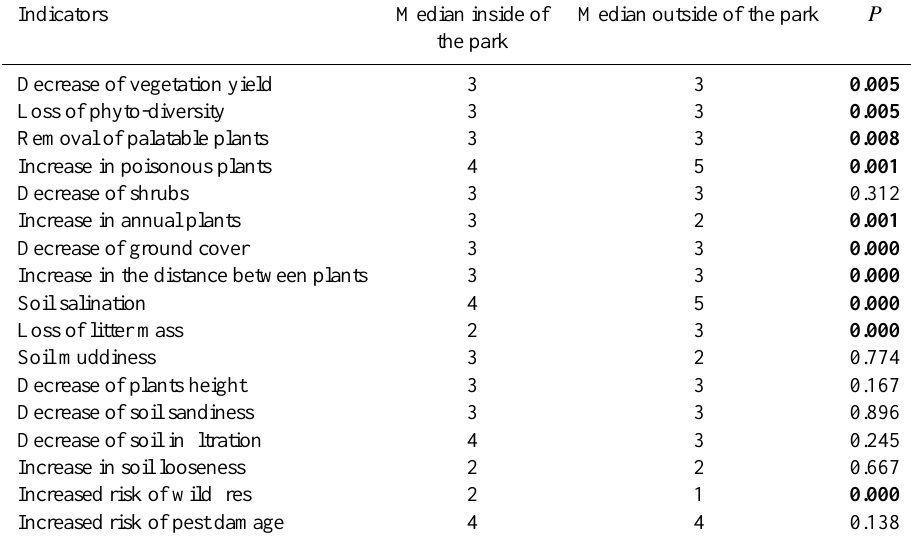
Table 2. Comparison of degradation indicators between inside and outside the park for both sites as total. P values below 0.05 are in bold. Indicators Median inside of Median outside of the park P the park Decrease of vegetation